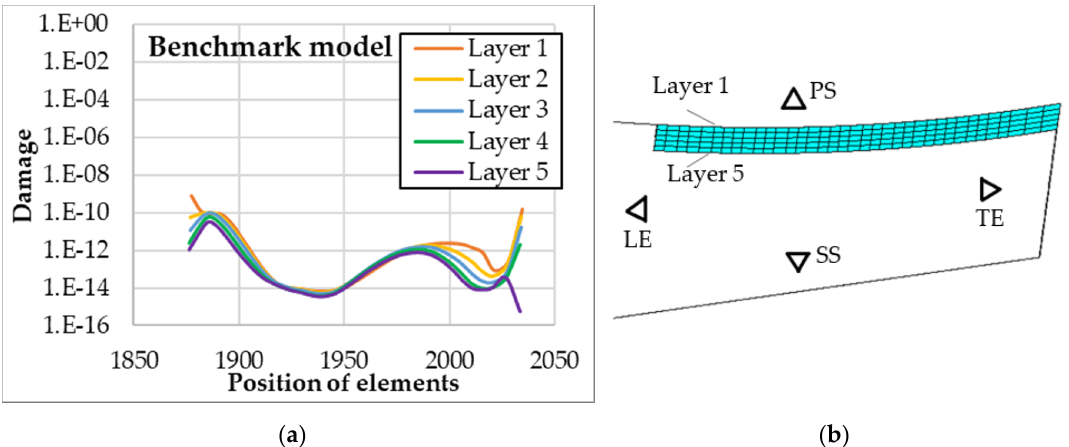
Figure 13. Damage results of the benchmark model: ( a ) Damage of the adhesive in the benchmark model; ( b ) Layer number of the adhesive mesh.